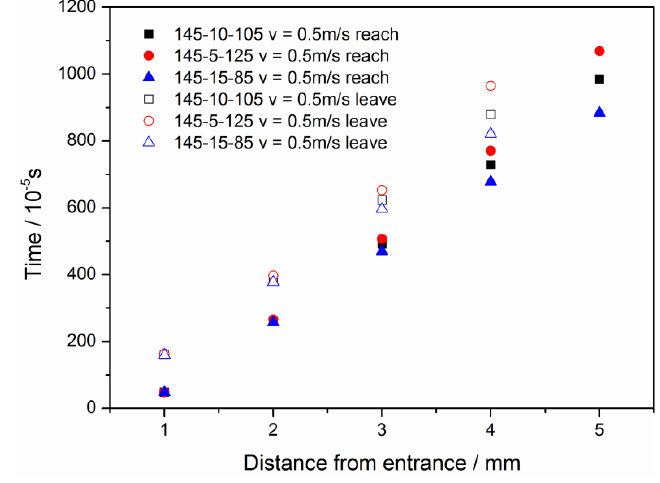
Figure 16. Comparison of times consumed with different modified GDL surfaces.